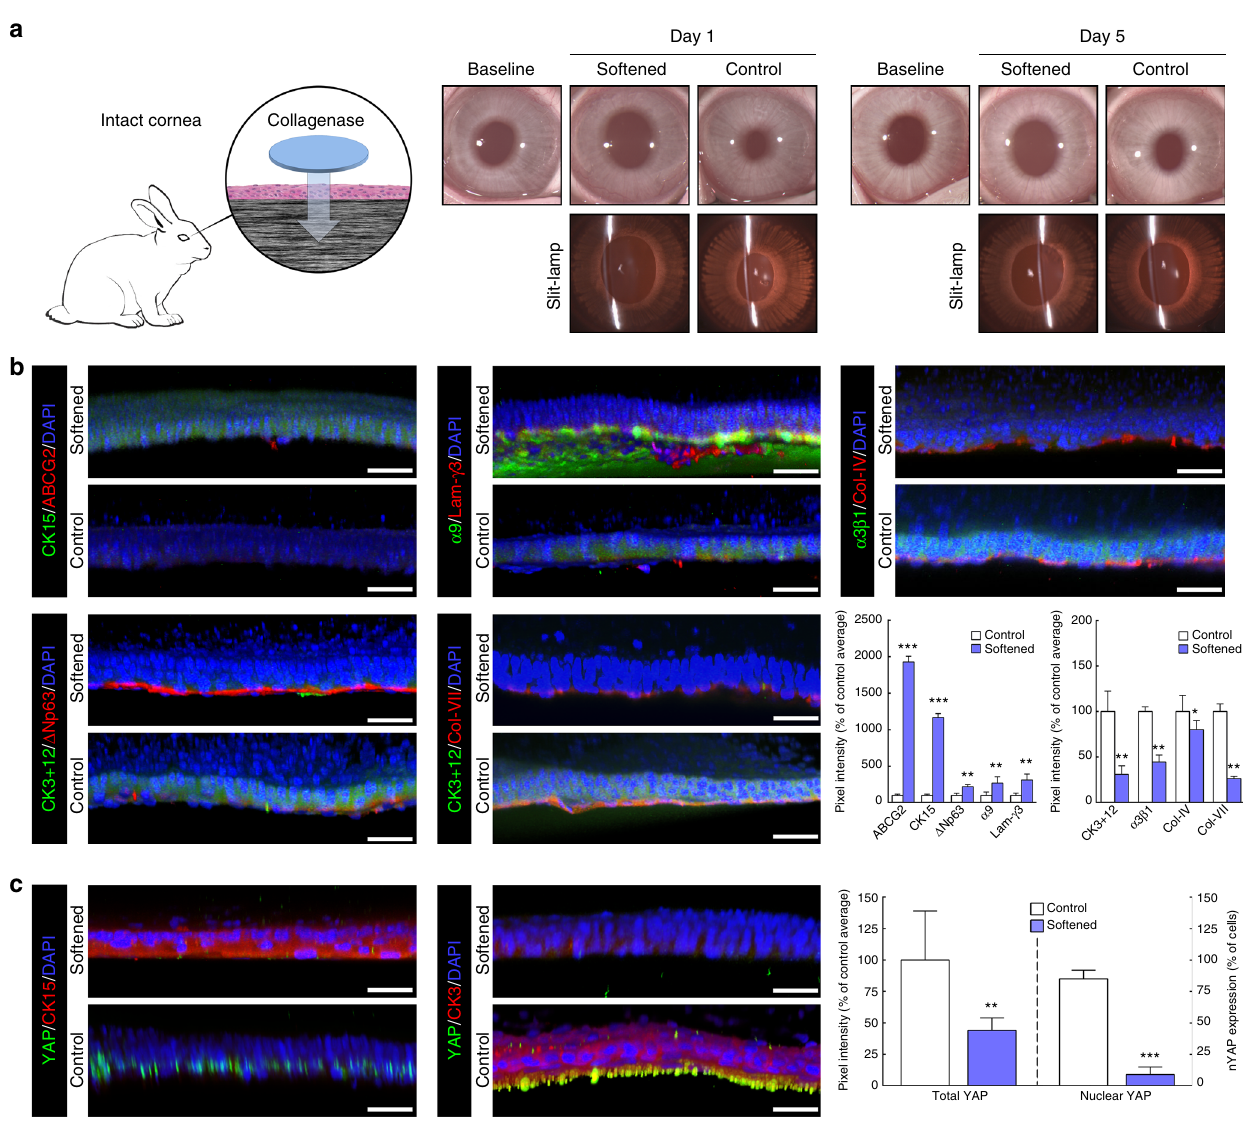
Fig. 5 Softening of central corneal tissue with collagenase increases expression of limbal markers in vivo. a Schematic representation of the collagenase treatment method used to soften the central region of intact corneas in live rabbits. Clinical observation and slit-lamp examination was performed 1 and 5 days post-intervention, and compared to pre-intervention results (baseline). The central corneal epithelium was also analysed by confocal immuno fl uorescence (3D reconstruction) 5 days after collagenase treatment (softened), and the corresponding marker expression was quanti fi ed. Cells on softened corneas expressed ( b ) higher levels of ABCG2, CK15, Δ Np63, integrin- α 9, and laminin- γ 3 (limbal markers) and lower levels of CK3 + 12 and integrin- α 3 β 1 (differentiation markers) compared to cells growing on the stiffer, untreated corneas (control). Collagen-IV and collagen-VII were also detected in collagenase-treated (softened) corneas, albeit at lower levels compared to control. c The expression of the mechanotransduction marker YAP was also signi fi cantly lower in the CK15-positive cells on softened corneas, where it mostly presented a non-nuclear (inactive) form compared to that in CK3-positive cells on untreated corneas (control). Cell nuclei were detected using DAPI. Scale bars, 50 µ m. Marker expression was represented as average ± S.D. from three independent experiments ( n = 3; *, **, and *** corresponds to p < 0.05, 0.01, and 0.001 after one-way ANOVA, respectively). Source data are provided as a Source Data fi